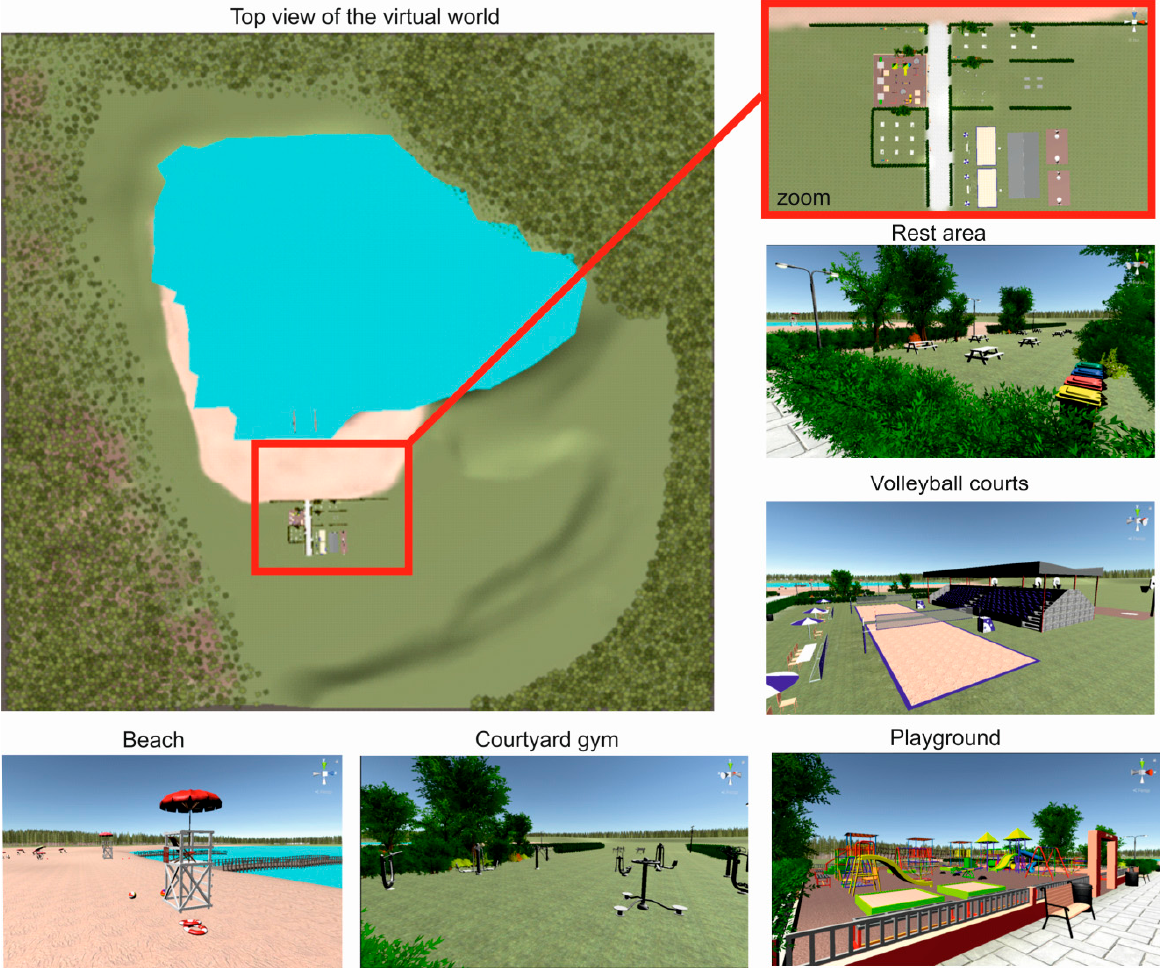
Figure 9. Proposed land development in the test area. Source: prepared by the author.